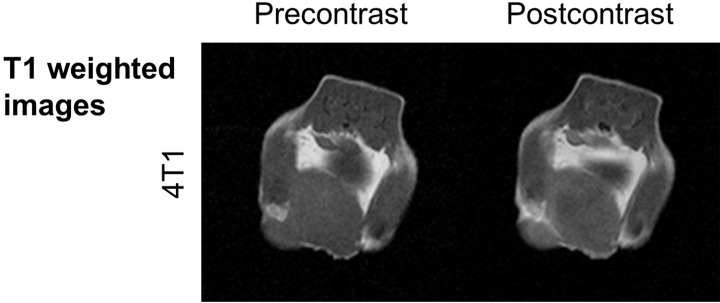
Gadopentetate does not delineate early necrosis.Axial T1 weighted MR images of the same 4T1 tumor as in Fig 1 at 60 seconds after intravenous injection of Gd-DTPA at a dose of 0.2 mmol/kg. Note homogenous tumor morphology with only slightly increased enhancement of the tumor periphery compared to the tumor center.